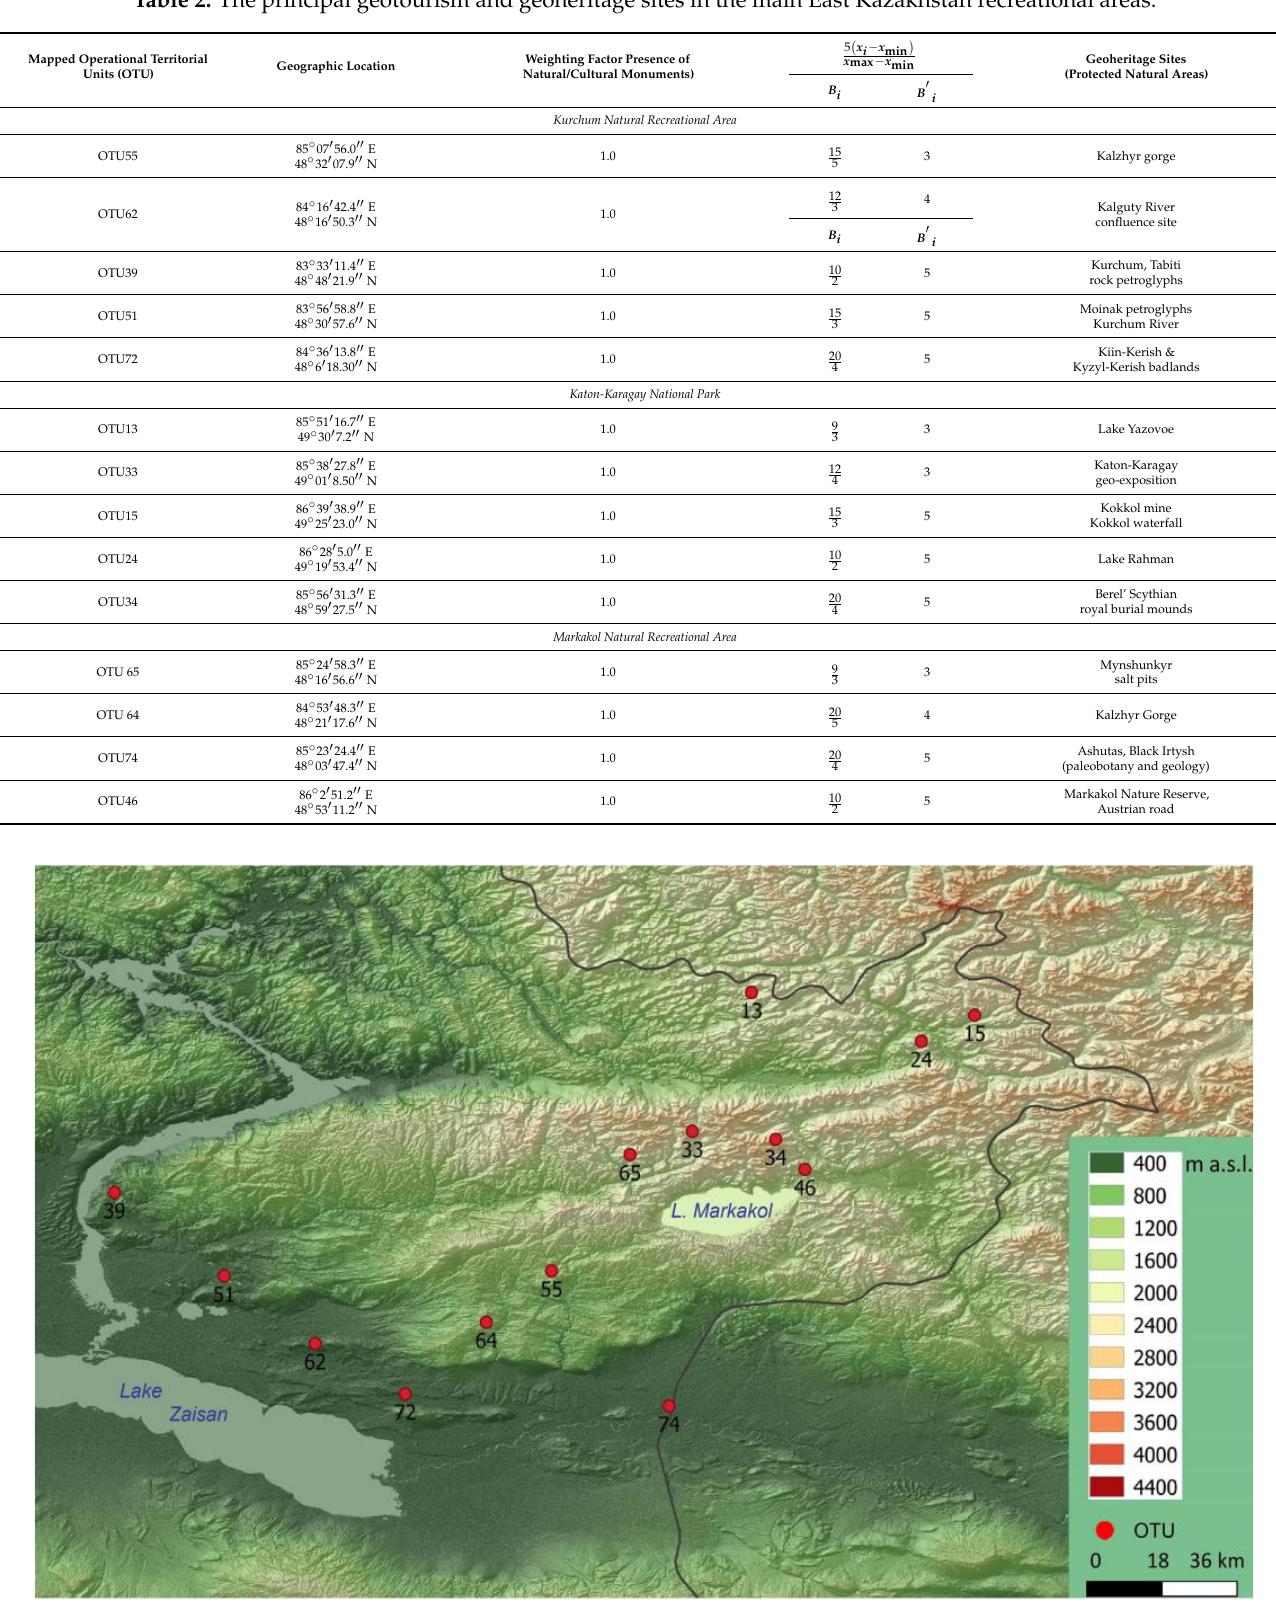
Figure 3. DEM map with projection of the most attractive tourism sites of the Southern Altai area.